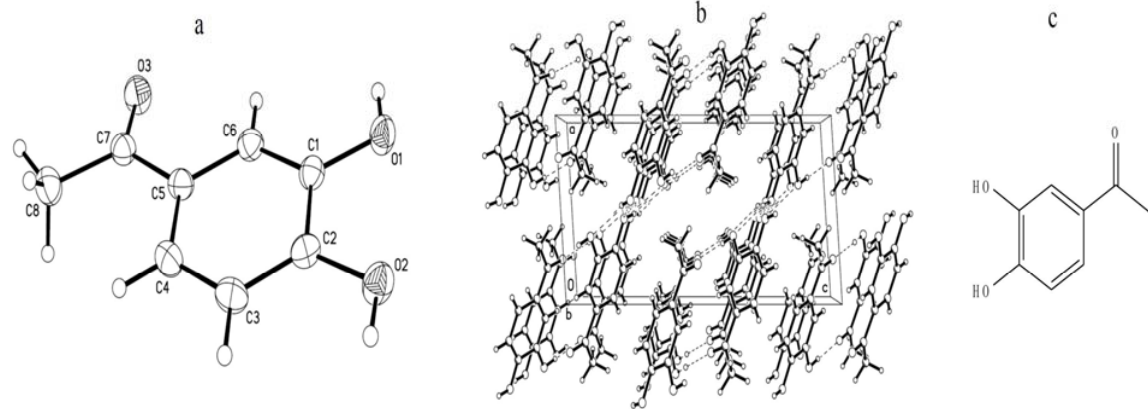
Figure 2. Chemical structure information of crystal sample (a: Crystal structure; b: Stacked crystal structure; c: molecule